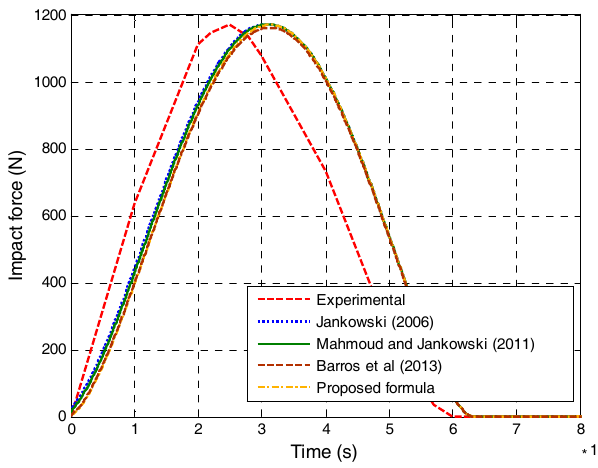
ff erent equations.